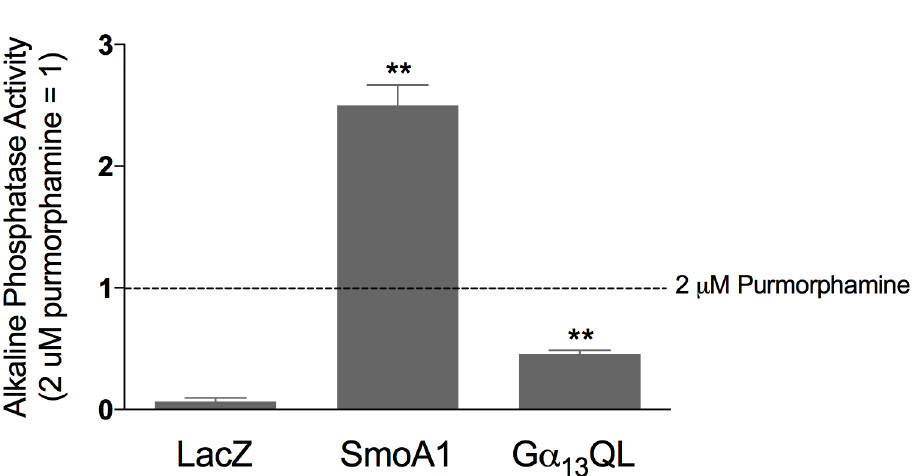
Fig 4. Alkaline phosphatase induction in response to SmoA1 and G α 13 QL. C3H10T1/2 cells were transduced with recombinant adenoviruses encoding LacZ, SmoA1, or G α 13 QL (MOI = 10) in the presence of DEAE-Dextran (10 μ g/ ml) then, together with cells exposed to 2 μM purmorphamine as a point of reference, cultured for 8 days in medium containing 50 μg/ml ascorbic acid and 10 mM β -glycerophosphate, at which point alkaline phosphatase activity was determined and normalized to that achieved with purmorphamine. The data are averages of 5 experiments, each performed in triplicate, ± SEM; (cid:3)(cid:3) , p < 0.01 relative to LacZ.